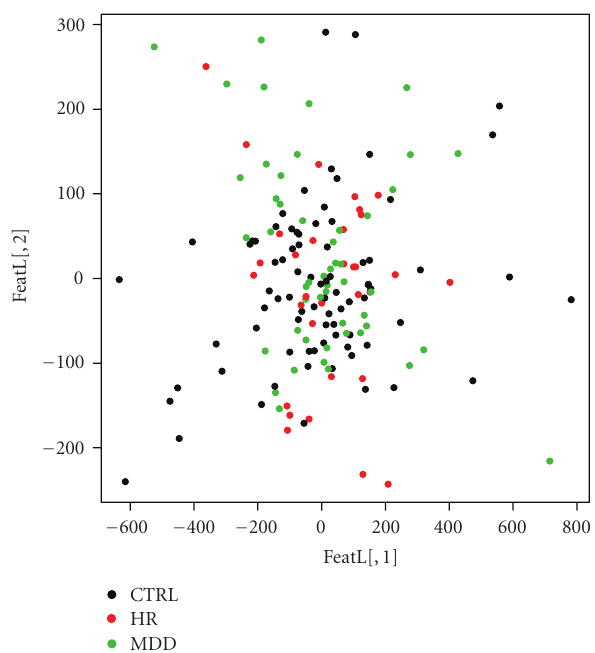
Figure 3: A multidimensional scaling scatter plot of D LM-Left mapped into R 2 . Little can be discerned from this plot regarding the relationship in hippocampus shape space of the three populations (MDD, HR, CTRL)—no class-conditional di ff erentiation is appar- ent.